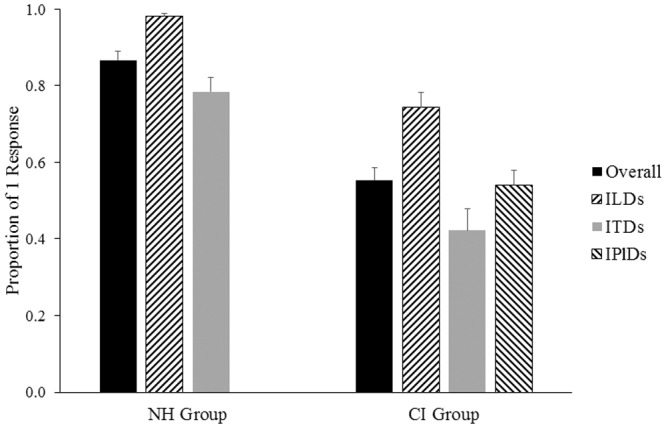
Mean (± 1SE) proportions of 1 response across all conditions are shown by the black bars.Overall CI listeners (n = 25 perceived 1 sound less frequency than NH peers (n = 24; p<0.0001). Mean (± 1SE) proportions of 1 response are also shown across each of the subtest conditions (ILDs = interaural/implant level differences; ITDs = interaural/implant timing differences; IPlDs = interaural/implant place of stimulation differences) tested in each group. In both groups, ILDs were most frequent perceived as fused and ITDs were least often perceived as fused (p<0.0001).